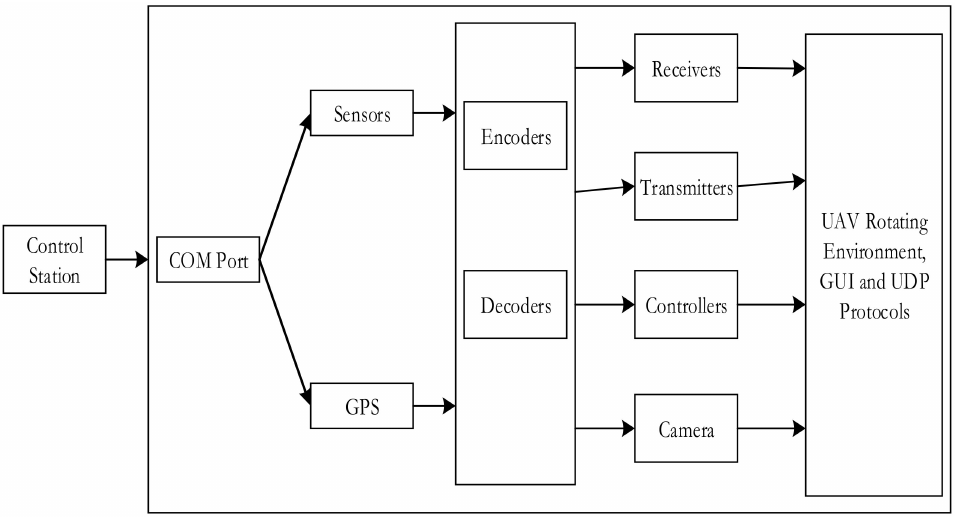
Figure 1. UAV architecture